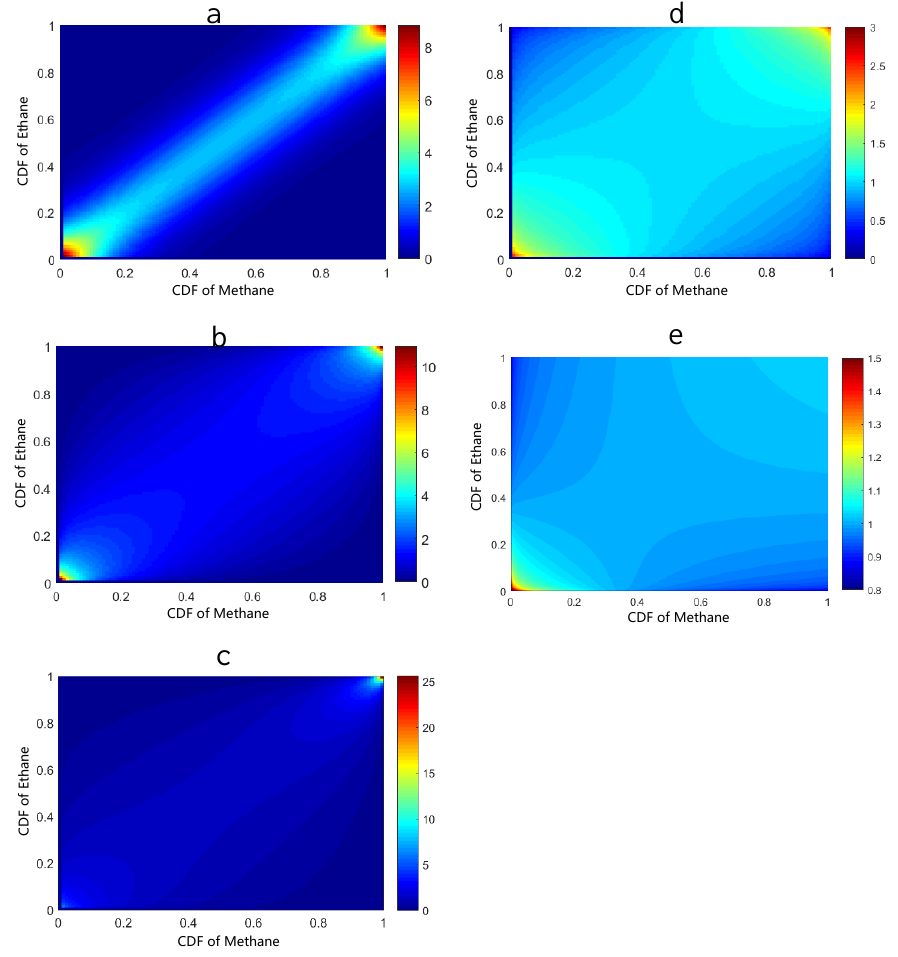
Figure 4. Copula function of the transformer oil color spectrum data fitting with methane and ethane. ( a ) Frank copula, ( b ) Gaussian copula, ( c ) Gumbel copula, ( d ) T copula, and ( e ) Clayton copula. Table 2. RMSE and NSE of different copula functions. Copula Function